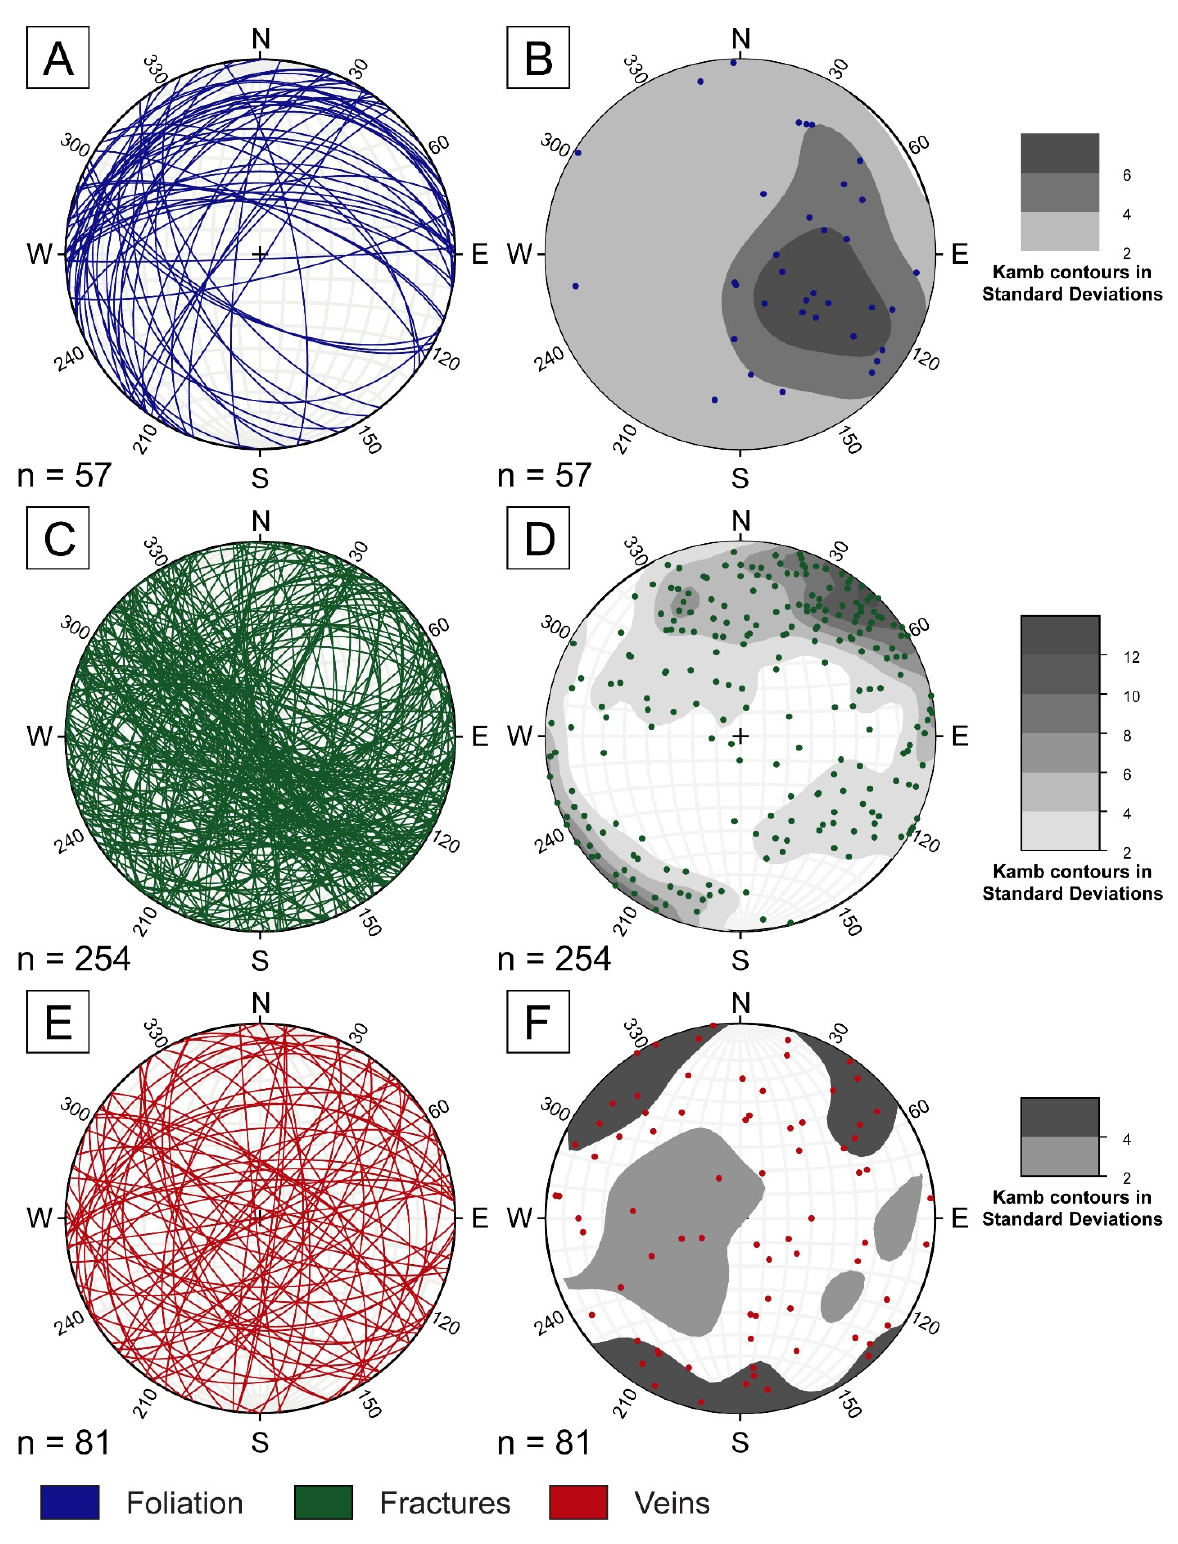
Figure 12. Planar and polar (pole-to-plane) plots with density contours of structures in the Sixtymile River area (field and drillhole data). ( A , B ) foliation; ( C , D ) fractures; ( E , F ) veins.